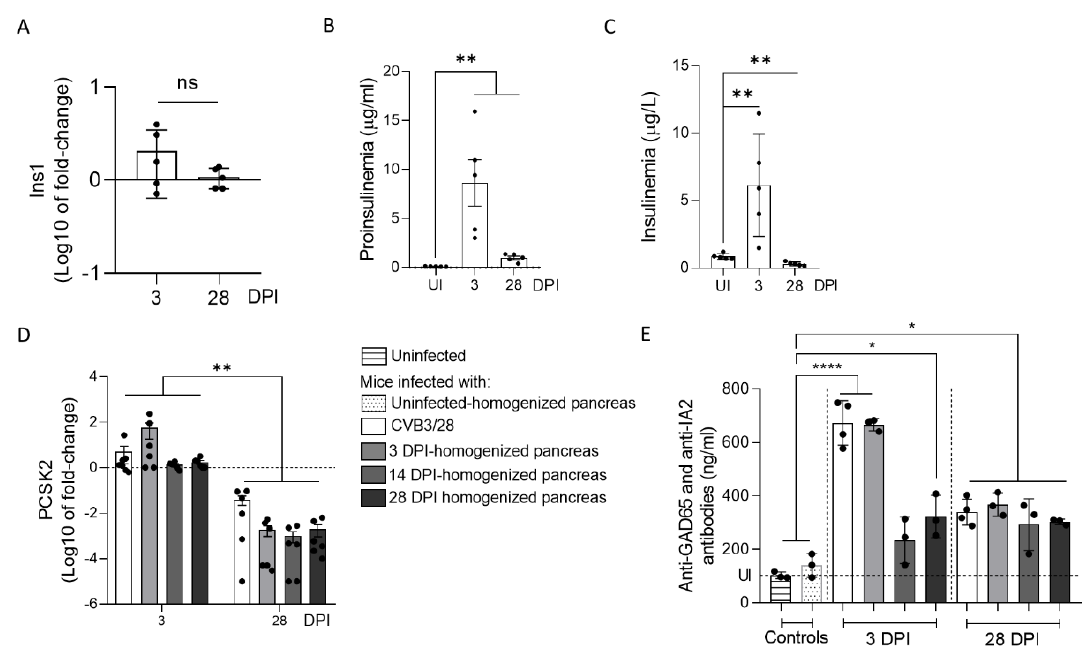
Figure 4. Impact of CVB3/28 and CVB-TD RNA populations’ infections on insulin maturation in pancreases of immunocompetent mouse. ( A ) Insulin (Ins1) mRNA levels’ fold-changes were measured by RT-qPCR in the pancreases of CVB3/28-infected mice at 3 and 28 days post-infection (DPI) ( n = 5). ( B ) Using specific murine proinsulin ELISA kit, proinsulin levels in blood were measured in uninfected mice and CVB3/28-infected mice at 3 and 28 DPI ( n = 5). ( C ) Blood insulin was measured using a specific ELISA kit in uninfected and CVB3/28-infected mice at 3 and 28 DPI ( n = 5). ( D ) PC2 (PCSK2) mRNA levels’ fold-changes were quantified by RT-qPCR in pancreases of CVB3/28-infected mice and of mice inoculated with homogenized pancreases from 3, 14 and 28 DPI ( n = 5). ( E ) Anti-GAD65 and anti-IA2 antibodies levels in the blood of uninfected mice, CVB3/28-infected mice and of mice inoculated with homogenized pancreases from uninfected, 3, 14 and 28 DPI mice, at 3 and 28 DPI ( n = 3 to 4) (uninfected mice were sacrificed at 3 or 14 DPI). Data represent mean +/ − SEM for three independent experiments. Mann–Whitney U test; *: p < 0.05; **: p < 0.01; ****: p < 0.0001. ns: non-significant. DPI: days post infection. Ins1: preproinsulin gene. PCSK2: Proprotein Convertase Subtilisin/Kexin Type 2. GAD65: glutamic acid decarboxylase 65. IA-2: islet antigen